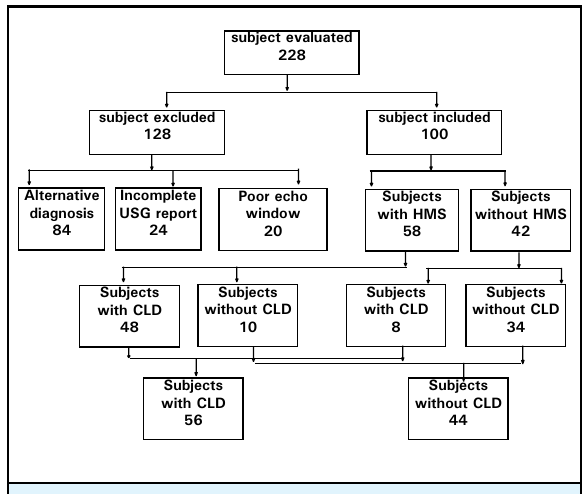
Figure 1. Distribution of study